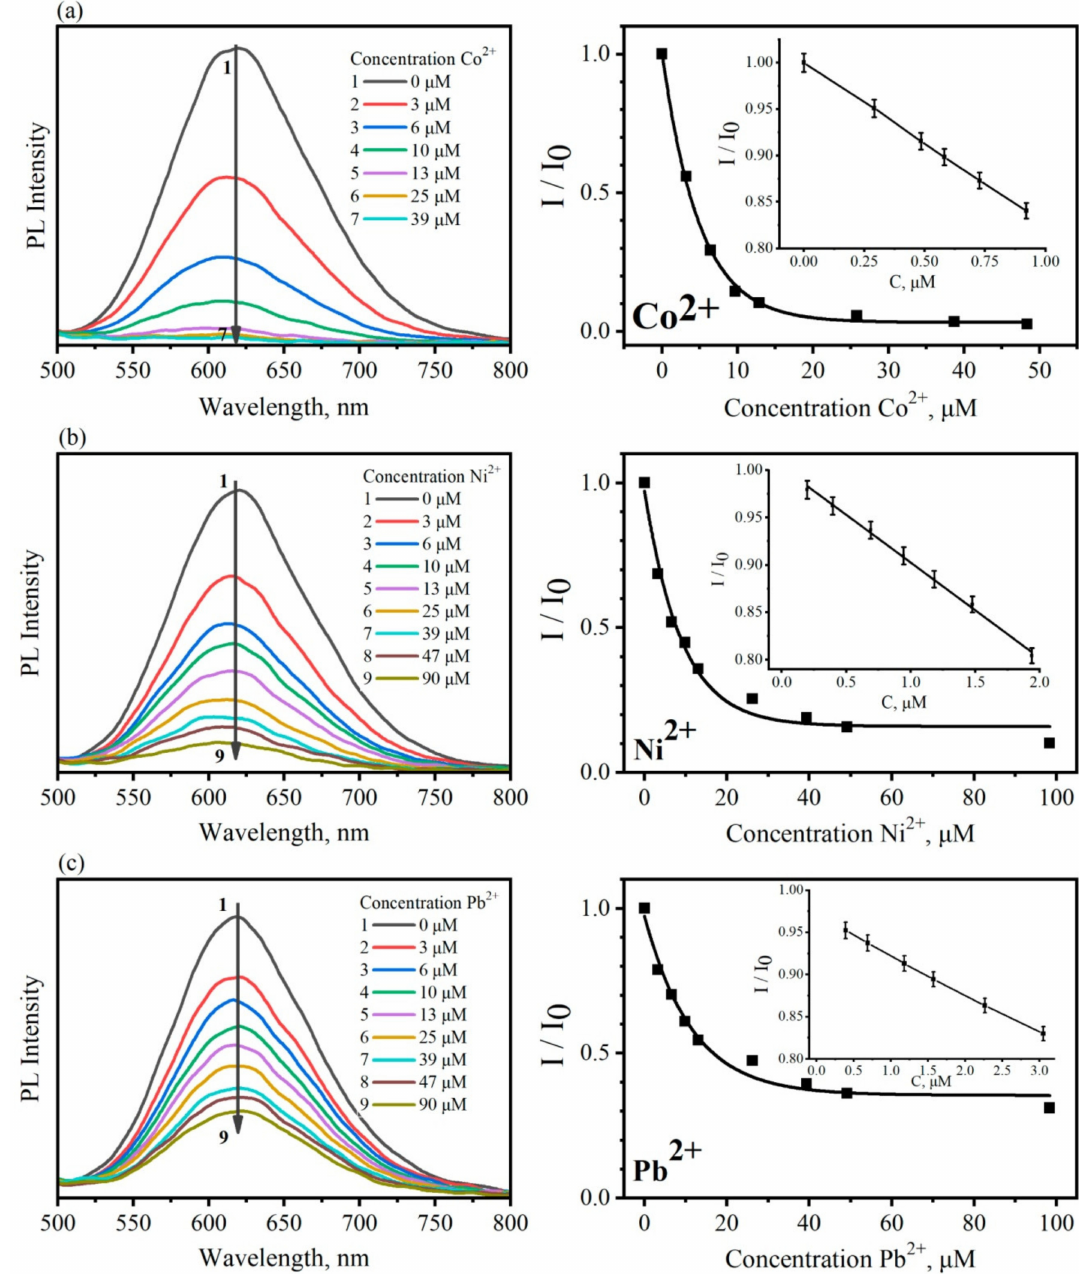
Figure 3. Quenching the CFA sensor luminescence upon increasing concentration heavy metal ions in aqueous solution. Left panel—PL band of CFA sensors as a function of the concentration of the Co 2 + , Ni 2 + , and Pb 2 + ions. Right panel—integrated luminescence intensity ratio (I 0 / I) dependence on the concentration of heavy metal ions for ( a ) Co 2 + , ( b ) Ni 2 + , ( c ) Pb 2 + ; insets show the regions of low ions